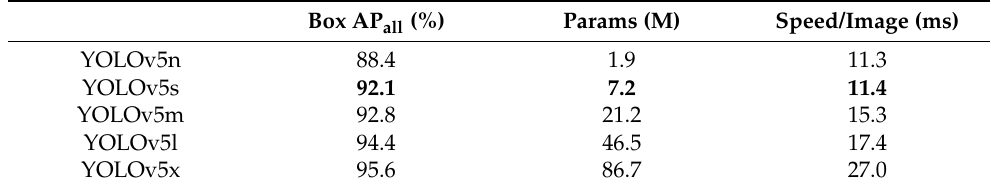
Table 2. Performance of different versions of YOLOv5 on the polished rice dataset. Box AP all (%) Params (M) Speed/Image